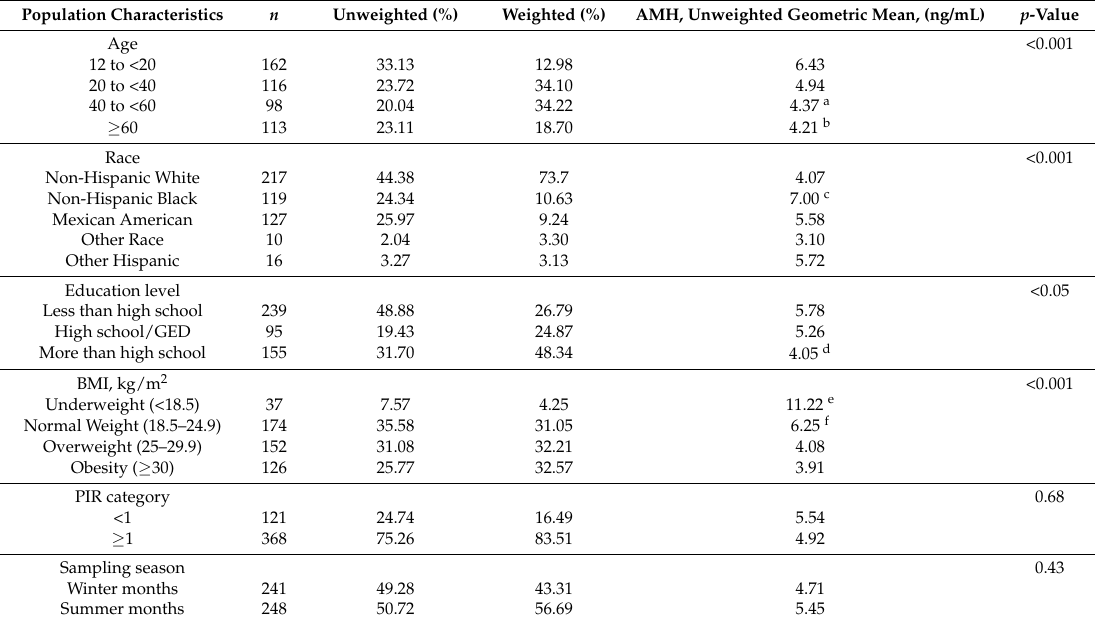
Table 2. Distribution of demographic and laboratory characteristics in NHANES (2003–2004) males and their Anti-Müller Hormone means ( n = 489).